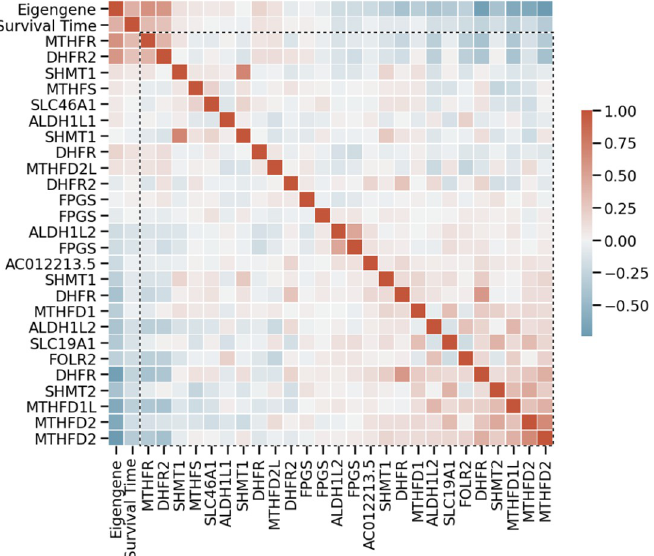
Fig 2. Heatmap of the coefficients of the Pearson correlation matrix between the variables survival time, the eigengene of the gene expression values, and the gene expression values within the pathway ‘Metabolism of folate and pterines” for samples from diseased patients. We sorted the genes in the expression matrix by their contribution to the eigensample and encompassed them with a dotted line. The patients’ survival time both correlates and anti- correlates with the different genes. However, the eigengene captures the covariational trend within the expression data and correlates well with the patients’ survival time.